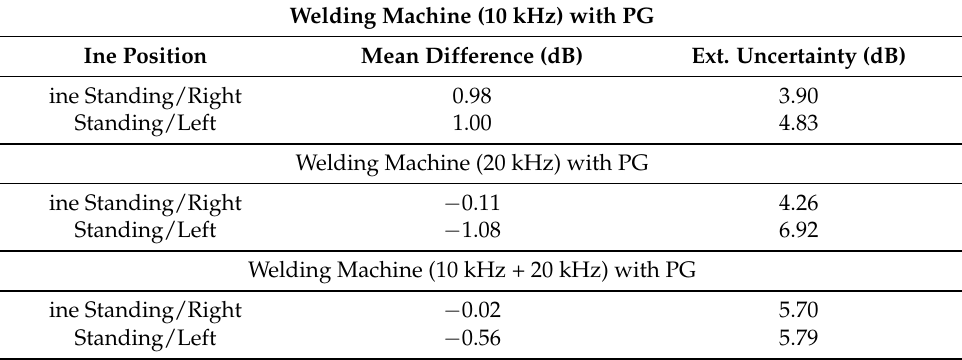
Table 2. Mean difference between the HiFUSPEx and the USPM, together with the extended mea- surement uncertainty calculated for measurements within the idealized set-up of a welding machine. Measurements performed with protection grid (PG) mounted on the microphone